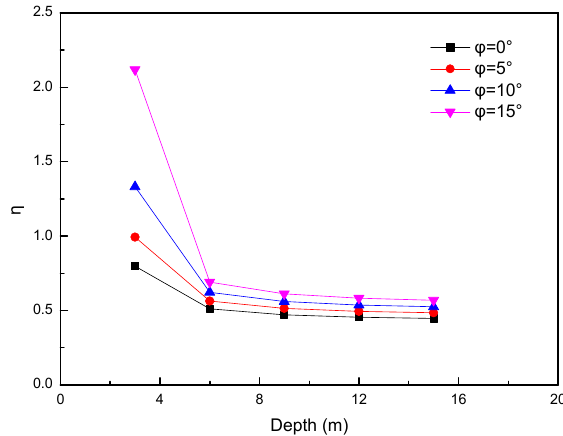
Figure 14. Influence of internal friction angle on η .